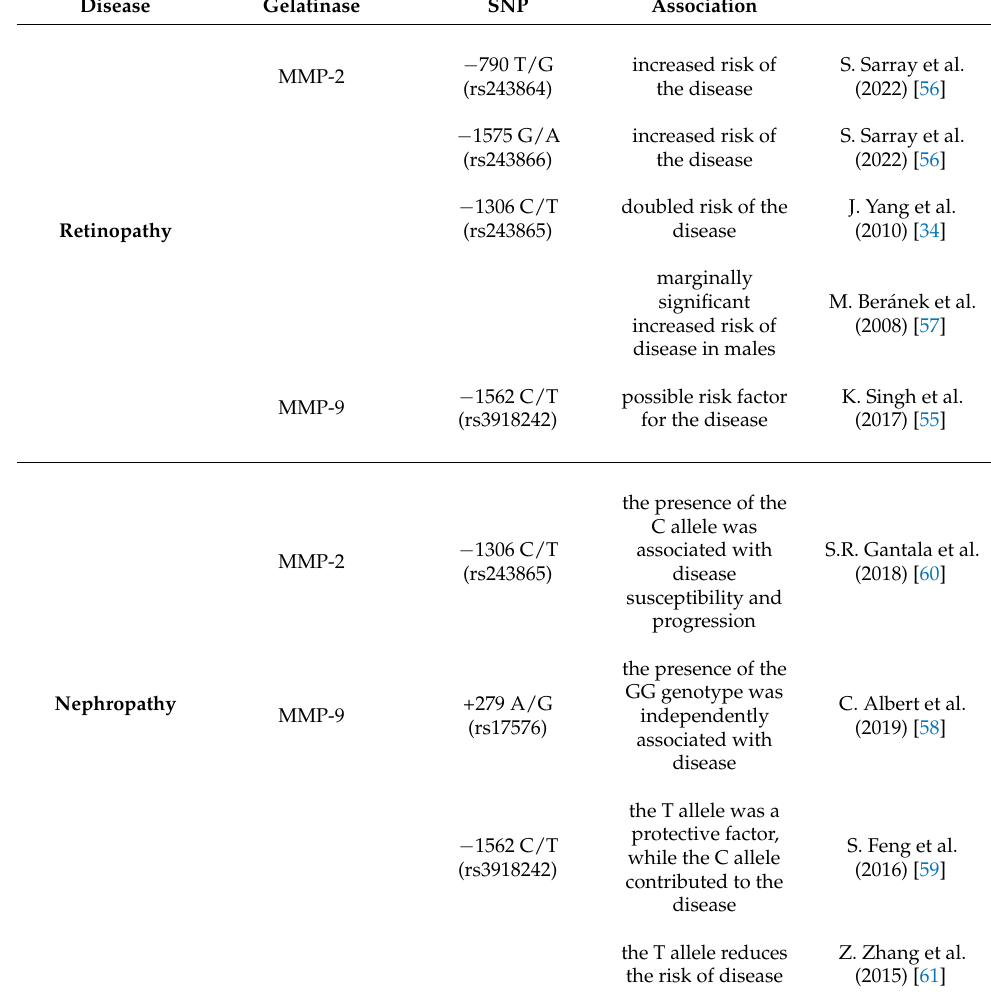
Table 4. Gelatinase polymorphisms in diseases accompanying type 2